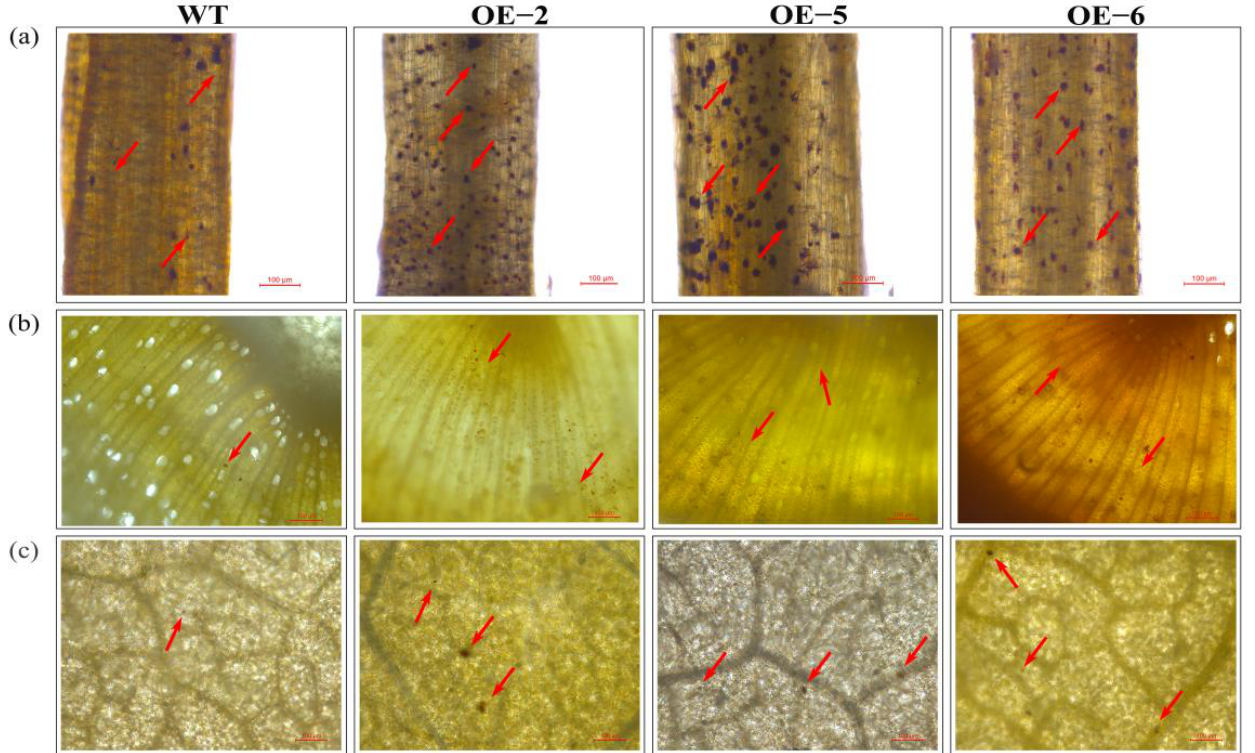
Figure 3. Cd localization of transgenic poplars and WT under 100 µ M CdCl 2 for 30 d. ( a ) Cd localization in the roots; ( b ) Cd localization in stems; ( c ) Cd localization in leaves. The red arrows indicate Cd-dithizone complexes.